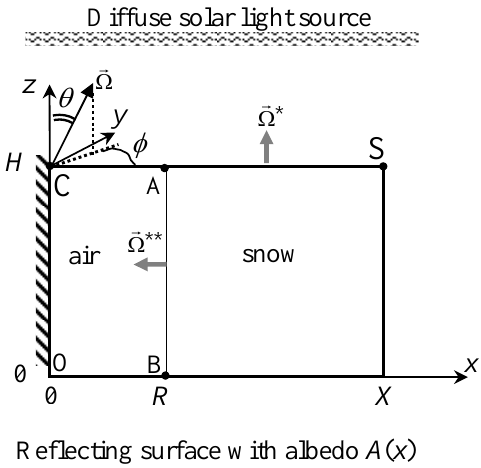
Diffuse solar light source